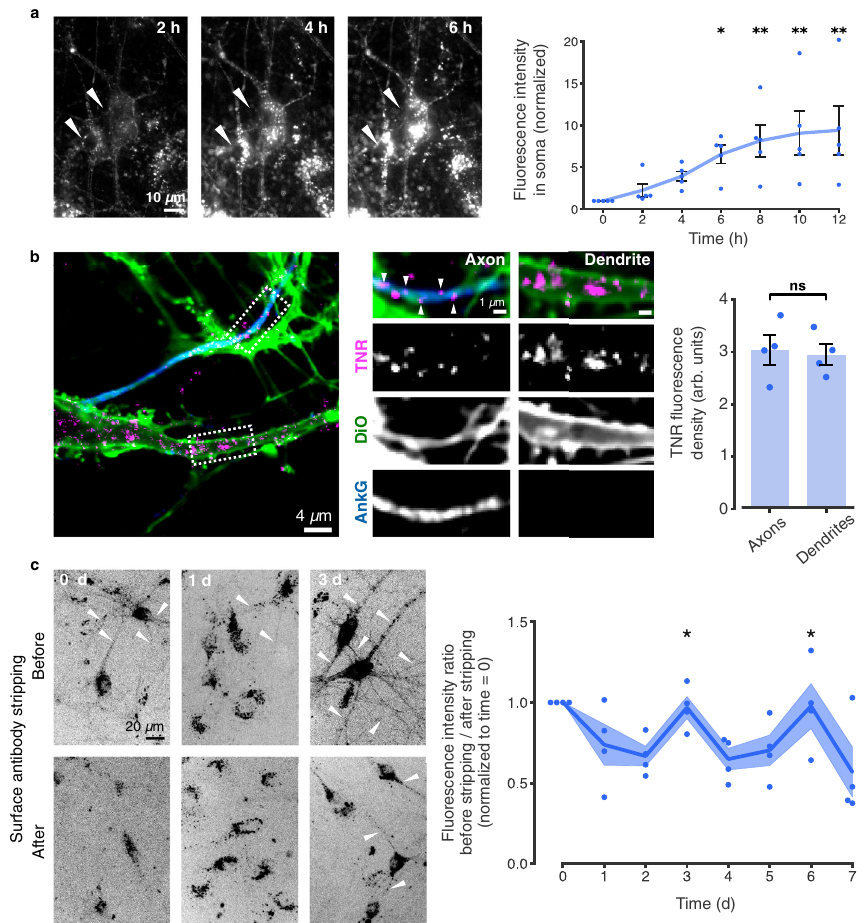
Fig. 4 Dynamic TNR molecules are endocytosed in neurons over hours, and recycle with a periodicity of ~3 days. a Newly-emerged TNR epitopes were labeled 4 h post-blocking, and monitored by live epi fl uorescence imaging. Arrowheads indicate neuronal somas. Scale bar = 10 µ m. Quanti fi cation of the intensity in somas (normalized to t 0 timepoint) indicates signi fi cant internalization. N = 5 independent experiments, 1-4 neurons per datapoint. Friedman test ( χ 2 6 = 25.46, ***p < 0.001), followed by two-sided Dunn ’ s multiple comparisons test ( ‘ 6 h ’ : * p = 0.033; ‘ 8 h ’ : ** p = 0.005; ‘ 10 h ’ : **p = 0.005; ‘ 12 h ’ : ** p = 0.002). Data represent mean ± SEM, dots indicate individual experiments. b Internalized TNR in axons vs. dendrites. Epitopes were allowed to internalize for 12 h, followed by surface stripping with proteinase K. The remaining signal was imaged with confocal microscopy in neurites visualized using DiO (green), with axons identi fi ed by immunostaining AnkyrinG (blue). Scale bar = 4 µ m (1 µ m zoom). Quanti fi cation of the signal density reveals no differences between dendrites and axons. N = 4 experiments, ≥ 10 neurons per datapoint. Two-sided paired t -test (t = 0.741, p = 0.513). Data represent mean ± SEM, dots indicate individual experiments. c Newly-emerged TNR epitopes were labeled 6 h post-blocking. The fraction present on the surface of neurites was measured at different intervals by imaging neurons in epi fl uorescence before and after stripping with proteinase K. Quanti fi cation of the fl uorescence ratio before/after stripping (normalized to the ‘ 0d ’ timepoint) reveals peaks of TNR resurfacing at 3 and 6 days post-labeling (~3 day periodicity). Amounts stripped at ‘ 3d ’ and ‘ 6d ’ are signi fi cantly higher than at ‘ 1d ’ and ‘ 2d ’ , or ‘ 5d ’ and ‘ 7d ’ . N = 4 independent experiments, 5 before/after images per datapoint. Kruskal-Wallis followed by Fisher ’ s LSD (Days 2, 3, 4: H 2 = 8.29, * p = 0.016, ‘ 3d ’ / ‘ 2d ’ ; *p = 0.046; ‘ 3d ’ / ‘ 4d ’ : * *p = 0.005; Days 4, 5, 6: H 2 = 6.74, * p = 0.036, ‘ 6d ’ / ‘ 5d ’ : * p = 0.022, ‘ 6d ’ / ‘ 7d ’ : * p = 0.028). Scale bar = 20 µ m. Data represent the mean (lines) ± SEM (shaded regions); dots indicate individual experiments. Source data are provided in Source Data fi